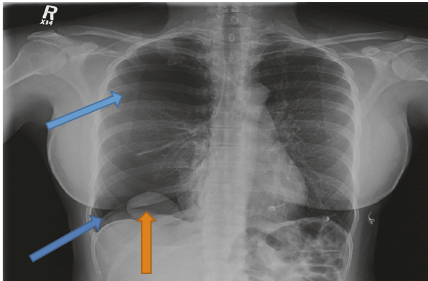
Figure 2: Coronal view of CT scan with orange arrow showing a 33